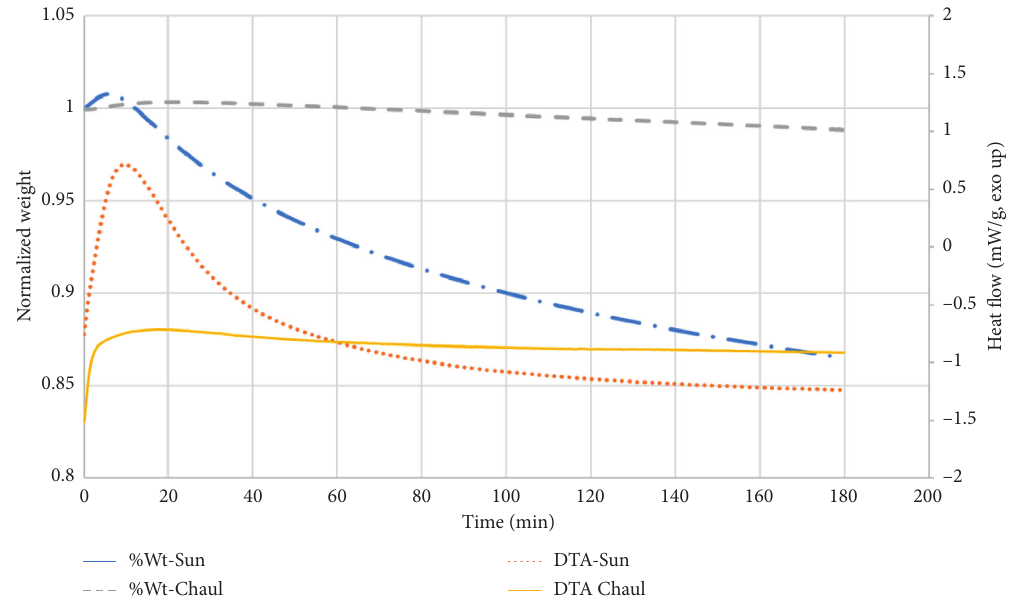
Figure 18: Isothermal TGA/DTA of chaulmoogra oil and sunflower oil in oxygen.